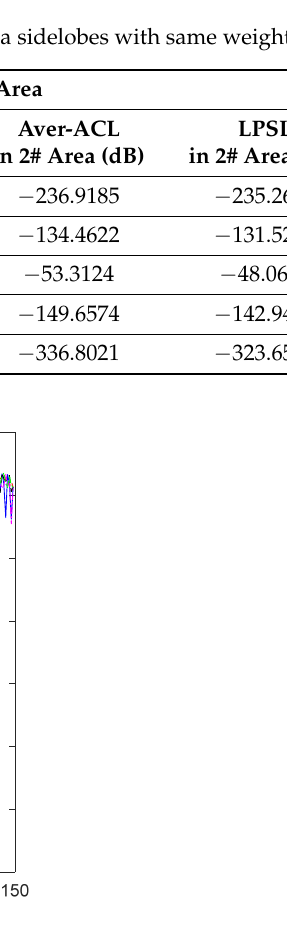
Figure 5. ACL comparison of suppressing sidelobes for multiple areas.